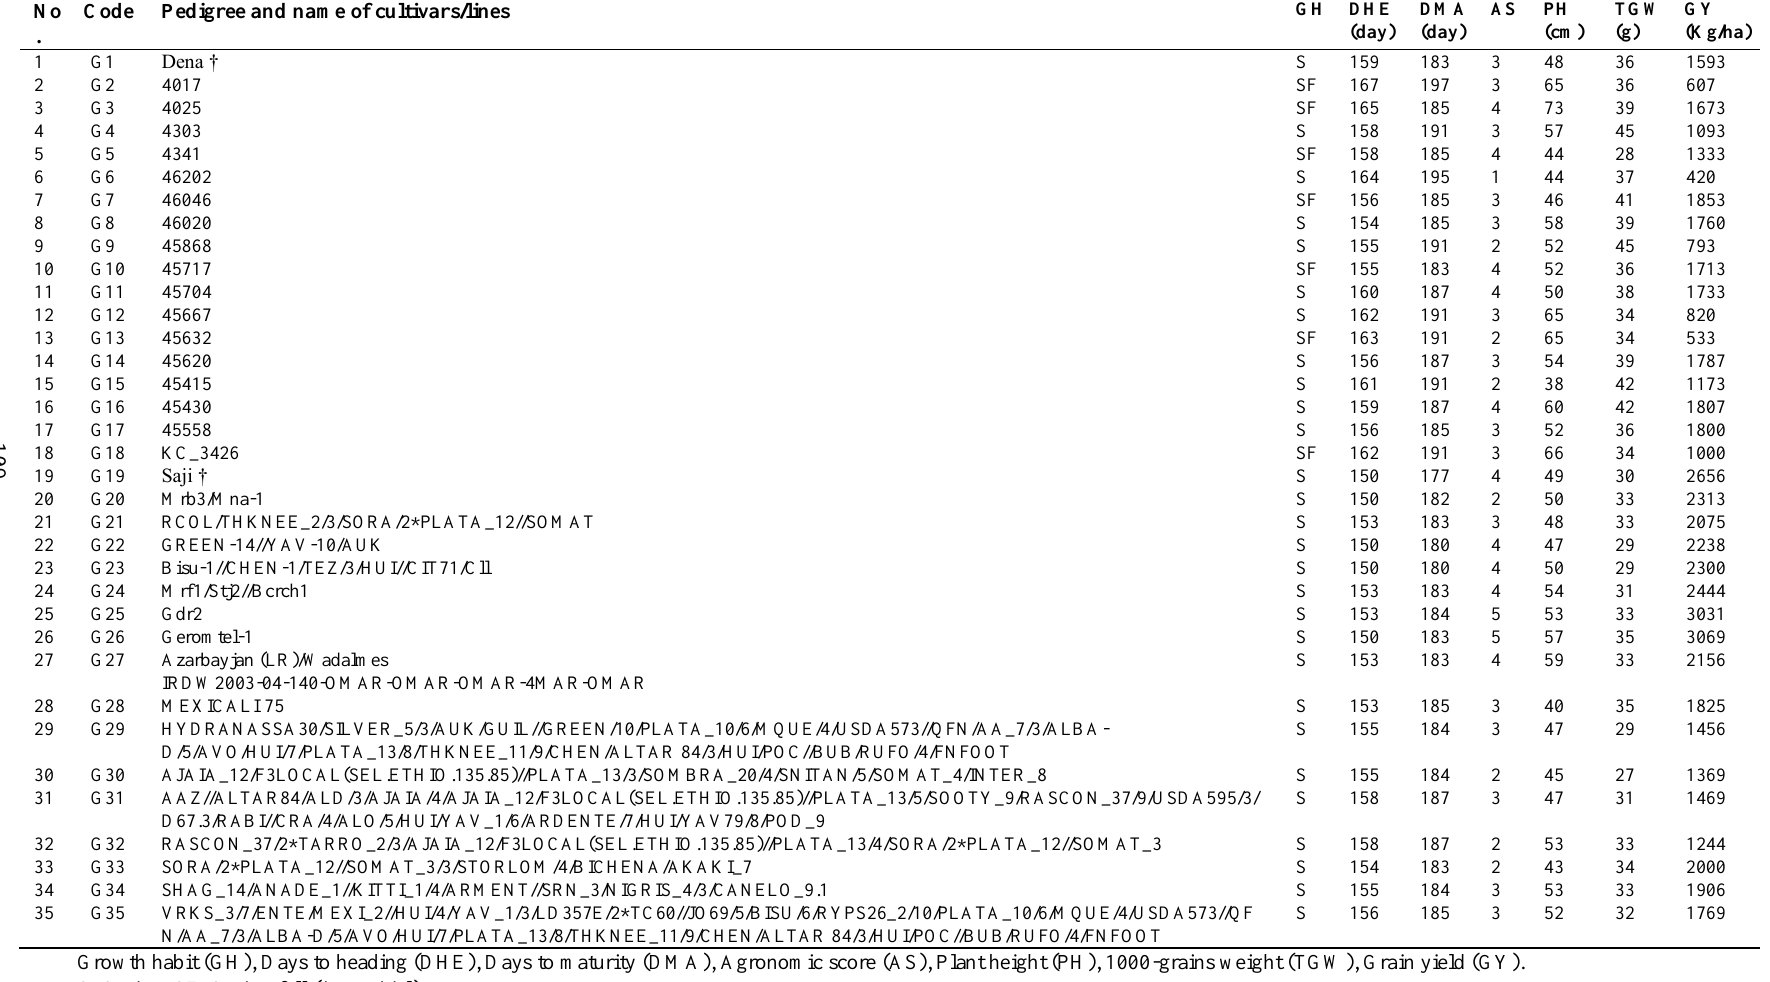
Growth habit (GH), Days to heading (DHE), Days to maturity (DMA), Agronomic score (AS), Plant height (PH), 1000-grains weight (TGW), Grain yield